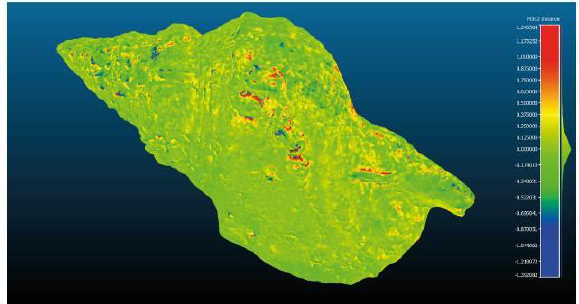
Figure 8. Error map with colored distances histogram